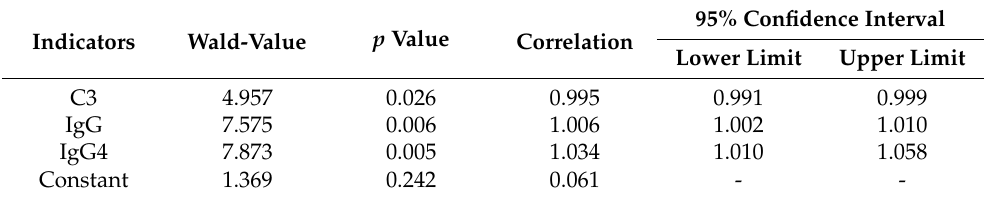
Table 2. Multifactor Logistic Regression Analysis of Differential Indicators between the LGBLEL patients and the Control